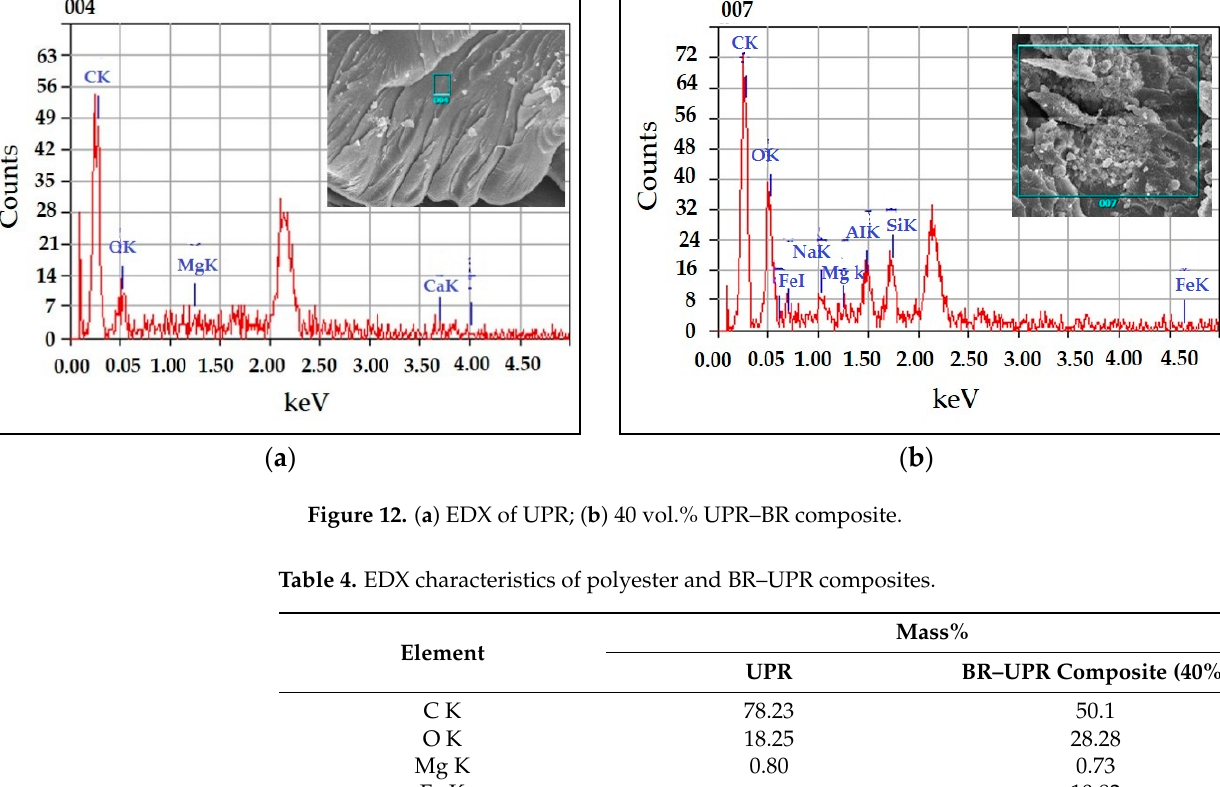
Figure 12. ( a ) EDX of UPR; ( b ) 40 vol.% UPR–BR composite.